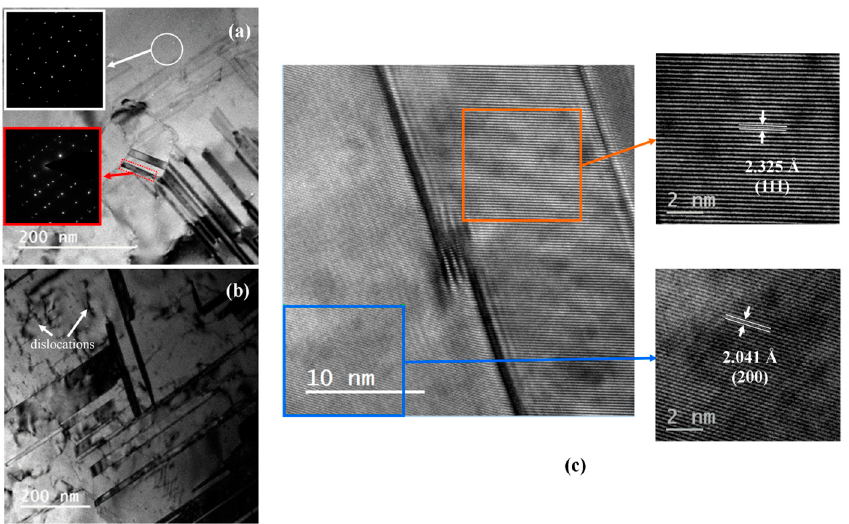
Figure 5. ( a ) The bright field TEM image from the plane view for Ag with selected area diffractions (SAD) patterns to illustrate the FCC structures ([110]) within the white area and nanocrystalline twining within the red area; ( b ) the TEM bright field image of nanocrystalline Ag with dislocations; and ( c ) the HRTEM images with areas in and out of the nanocrystalline twining.